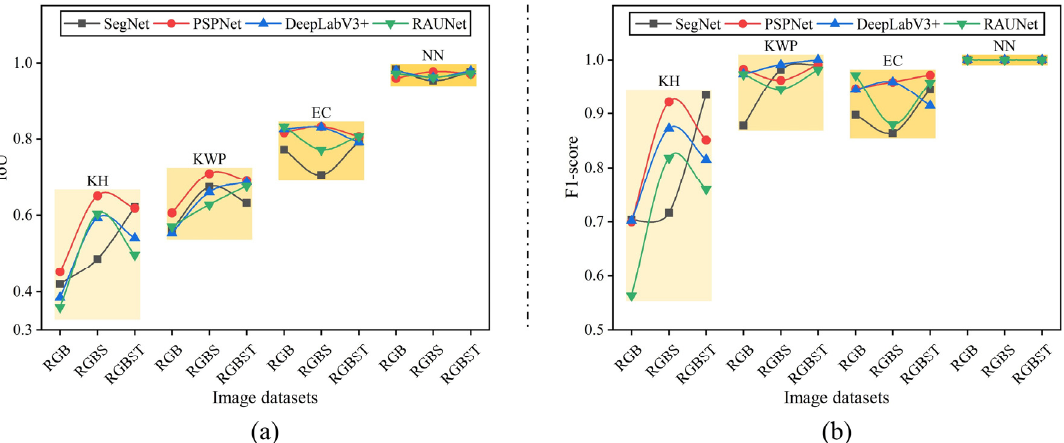
Figure 13. Statistics of accuracy of OCC models for karst wetland vegetation. ( a ) IoU, ( b )